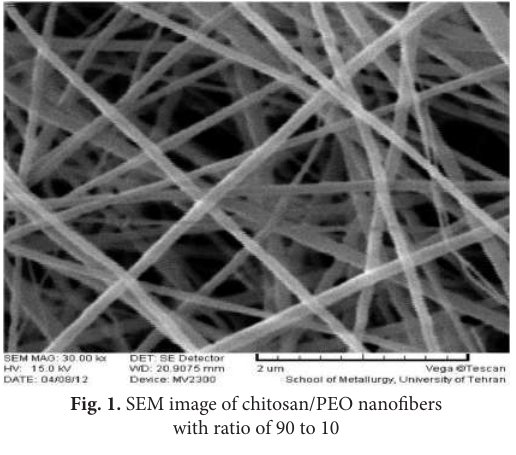
Fig. 1. SEM image of chitosan/PEO nanofibers with ratio of 90 to